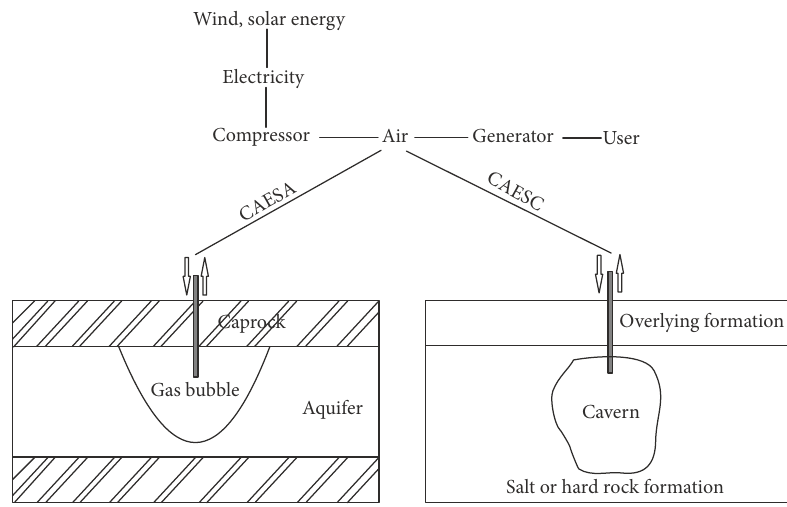
Figure 1: Schematic diagrams of CAESA and CAESC